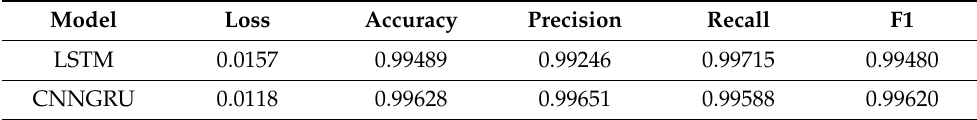
Table 2. Comparative performance of LSTM and CNNGRU models.